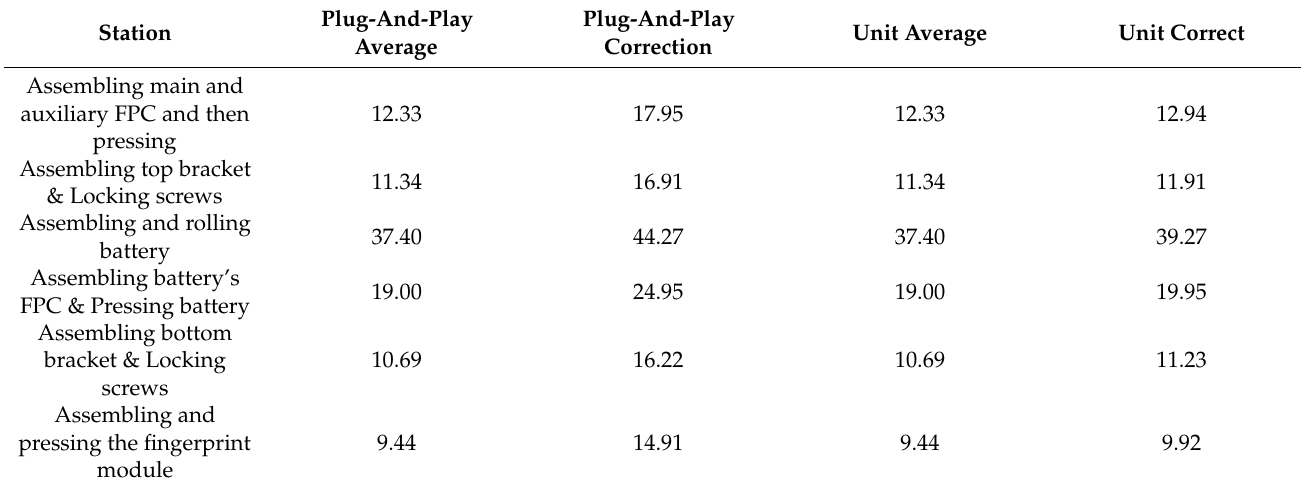
Table 4. Working Hours of Semi-automated Procedures.